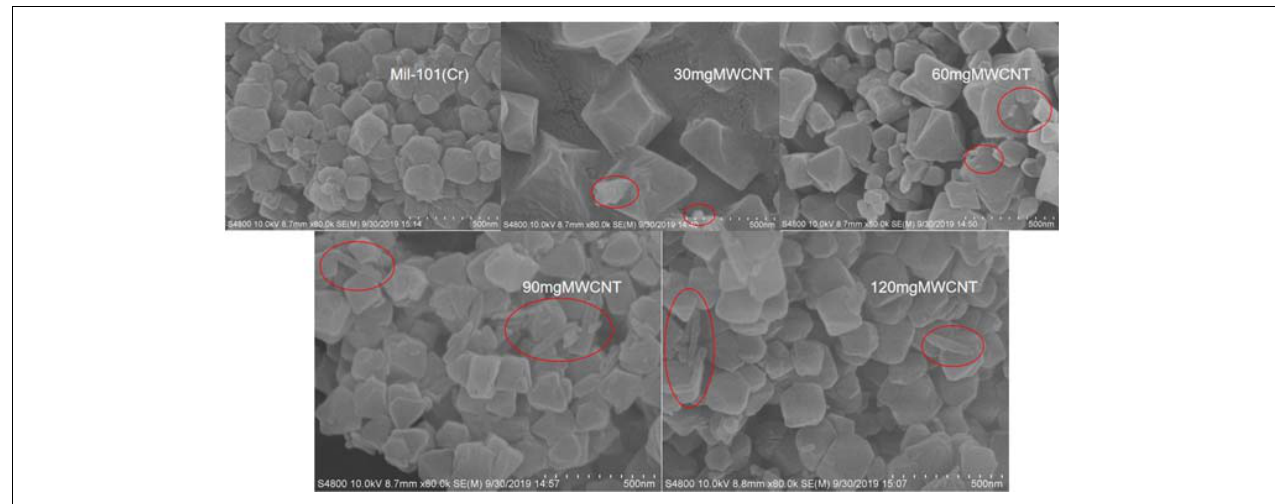
FIGURE 3 | SEM of crystal analysis of carbon nanotubes calcium chloride mil 101 (Cr) composite (The red circle shows the free state of the carbon nanotubes).